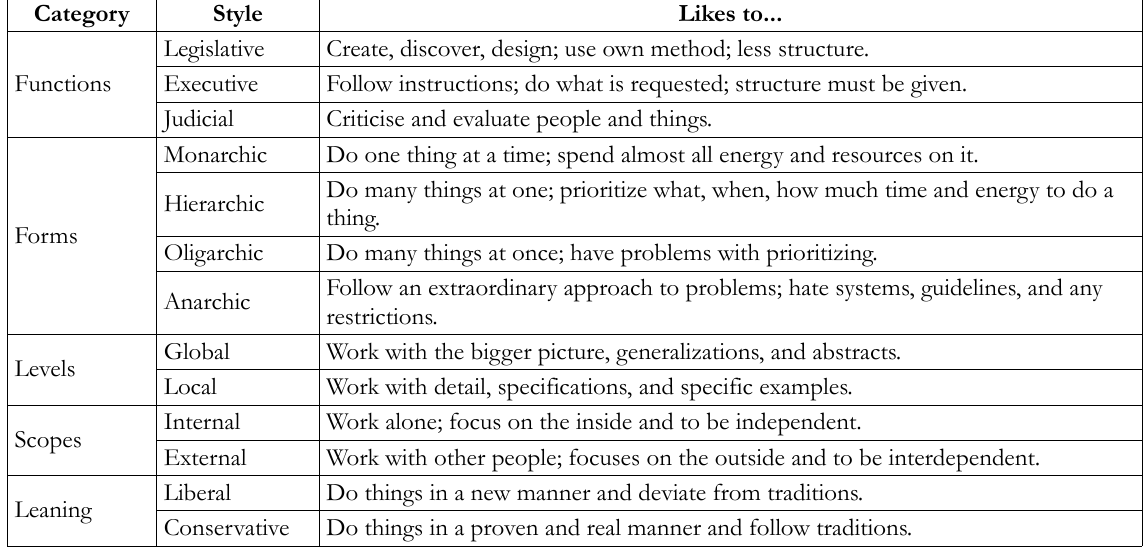
Table 1. Thinking styles dimensions and meanings according Sternberg-Wagner